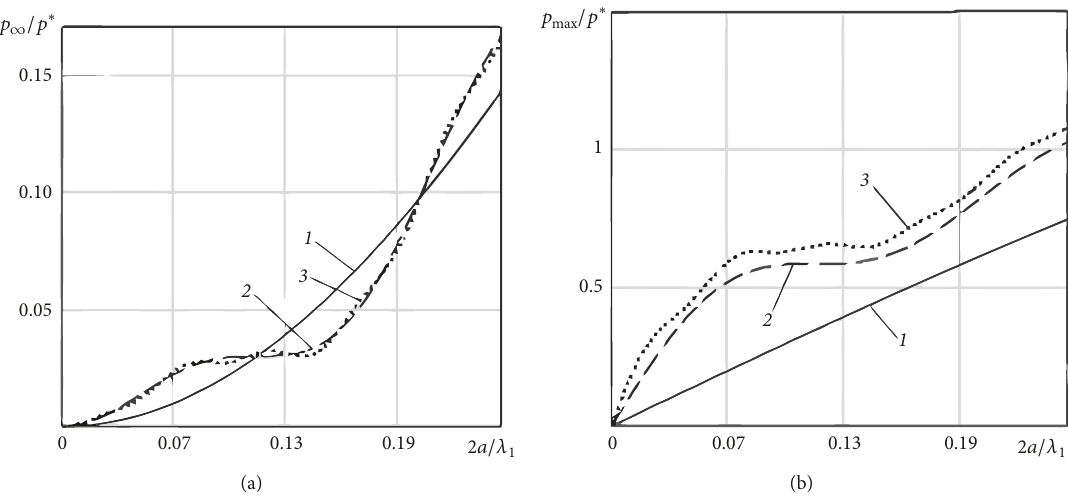
Figure 5: Dimensionless mean pressure (a) and maximum pressure (b) as a function of dimensionless contact length for profiles with different numbers of cosine harmonics ( 𝜆 1 = 2 𝜋 , Δ 1 = 0.5): f ( x ) = Δ 1 cos (𝑥) ( 1 ); f ( x ) = Δ 1 cos (𝑥) +0.02 Δ 1 cos (11𝑥) ( 2 ); f ( x ) = Δ